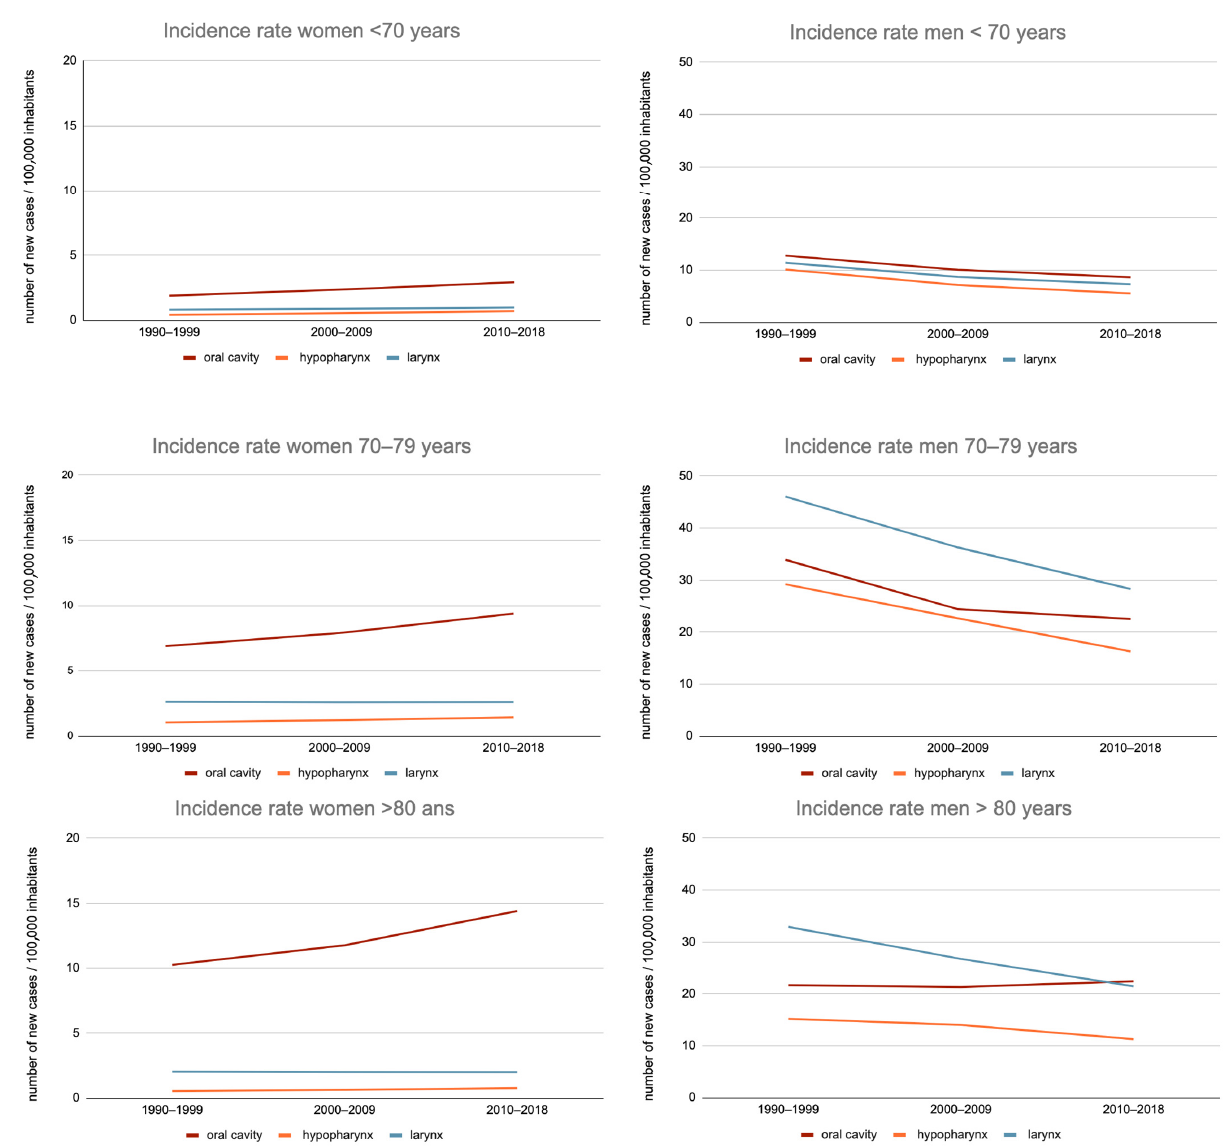
Figure 1. Evolution of the incidence rate of the oral cavity, hypopharynx, and larynx cancer in France, between 1990–1999 and 2010–2018, by sex, among subjects aged less than 70 years, 70 to 79 years, and 80 years or more.